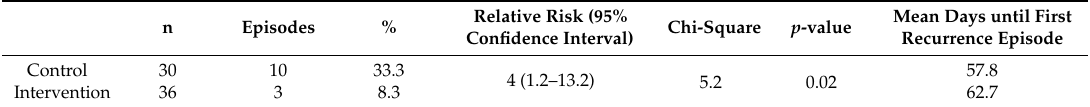
Table 2. Low Back Pain (LBP) exacerbation recurrence episodes during the follow-up.